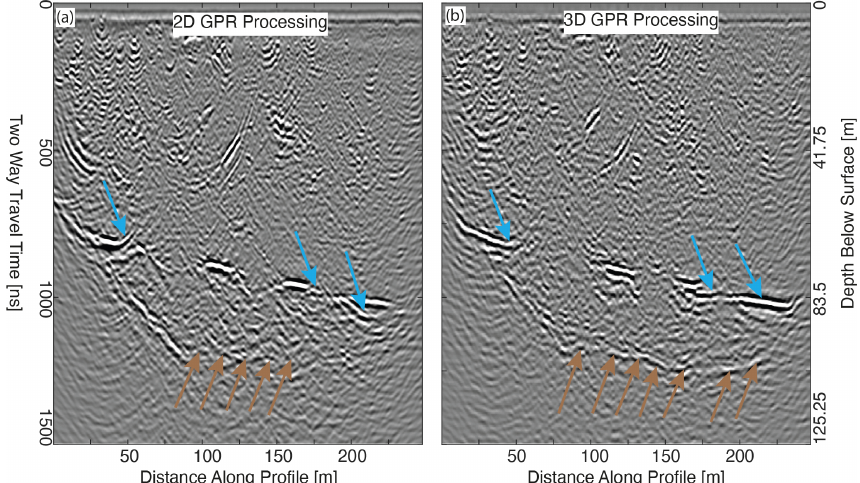
Figure 7. (a) A single GPR data profile processed using with a 2D GPR workflow. (b) Single line extracted from multiple GPR profiles processed using a 3D GPR